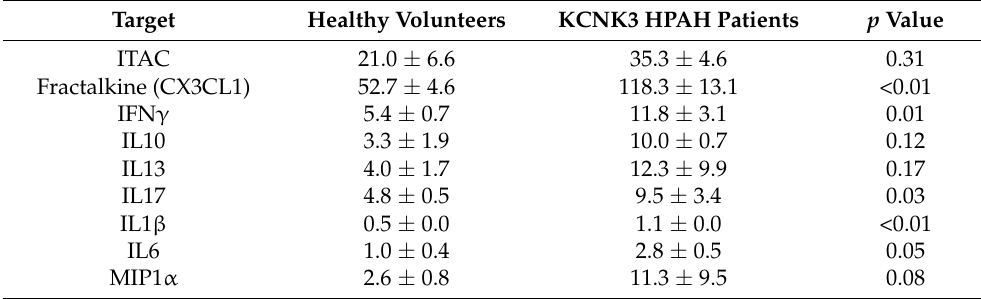
Figure 6. IHC and CyTOF assessment on human tissue samples validate the role of inflammation in driving KCNK3-PAH. ( A ) Immunofluorescence depicting increased numbers CXCL9 + cells (red) in the KCNK3 patient lung, around the muscularized vessels (green), 400X magnification. ( B ) 2D density contour expression of mass immunotyping of KCNK3 PBMCs. ( C and D ) Naïve T cells are downregulated in KCNK3 PBMCs, compensated through the upregulation of central and memory cells in CD4 + and CD8 + population. ( E and F ) CyTOF findings verify the role of cell mediated immune response in KCNK3 subjects through the dysregulation of CXCR3 + , CX3CR1 + , CCR4 + , CD127 + CD8 + and PD1 + CD8 + cells. Table 4. Plasma cytokines of PAH patients with KCNK3 mutation. Mean cytokine levels (pg/mL) from the healthy volunteers ( n = 7) and PAH patients with KCNK3 mutation ( n = 2). Plasma collected from the subjects were assessed for cytokine levels on multiplex platform. Mean cytokine level of each analyte is the average of duplicates. Data was analyzed by unpaired, parametric t-test with Welch’s